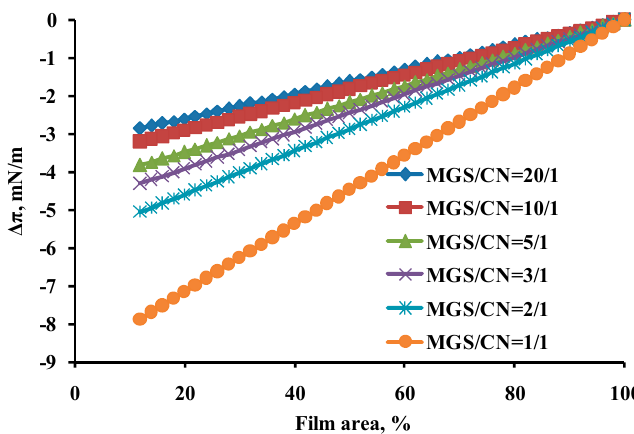
Figure 5. Interaction parameter Δπ calculated from the isotherms at Figure 2 using Equation (1) (see Section 4.2.1).